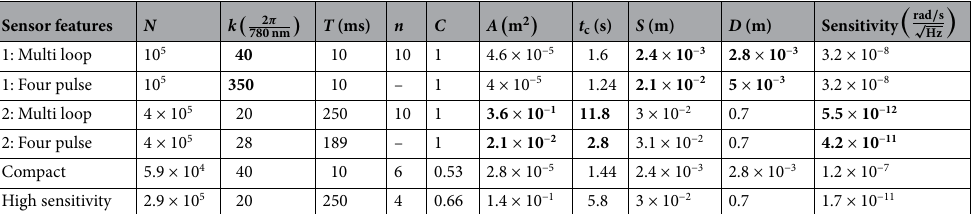
Table 1. Comparison of our multi-loop scheme with a four-pulse interferometer and performance estimation. We base our calculations on rubidium atoms 49 , a number of N detected atoms, an effective wave number k , a pulse separation time T (see Fig. 2), and a contrast C , performing 2 n loops. We denote A as the effectively enclosed area, which scales with n . Both the calculation of A and the sensitivity neglect finite pulse durations. The maximum trajectory separation is given by S . For the estimation of the drop distance D with regard to a compact scenario we allow for additional time of 6 ms for the momentum transfer. Our interferometer cycle time is denoted by t c and we state the sensitivity in the shot-noise limit according to Eq. (4). In the first four rows we compare calculated parameters of multi-loop interferometers to four-pulse geometries without a relaunch 5,7,9 , emphasising differences in the parameters in bold, and neglecting atom losses and contrast reduction due to imperfect beam splitters. For the lower two rows, we assume a simple model in which the contrast for multiple loops C ( n ) decreases depending on the number of loops n scaling as C ( n ) C (1) denoting the contrast for a single loop. Furthermore, our model reduces the number of detected atoms by a factor l n − 1 with